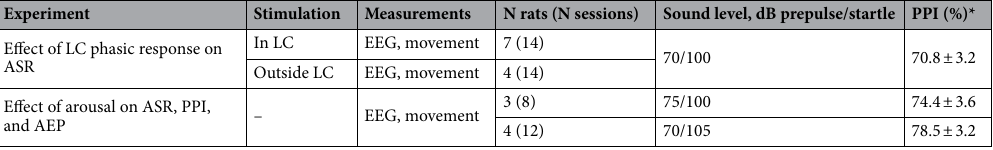
Table 1. Experimental groups and sound parameters. *Mean ± s.e.m are shown; %PPI did not differ between groups (one-way ANOVA, F 2, 47 = 1.1, p =